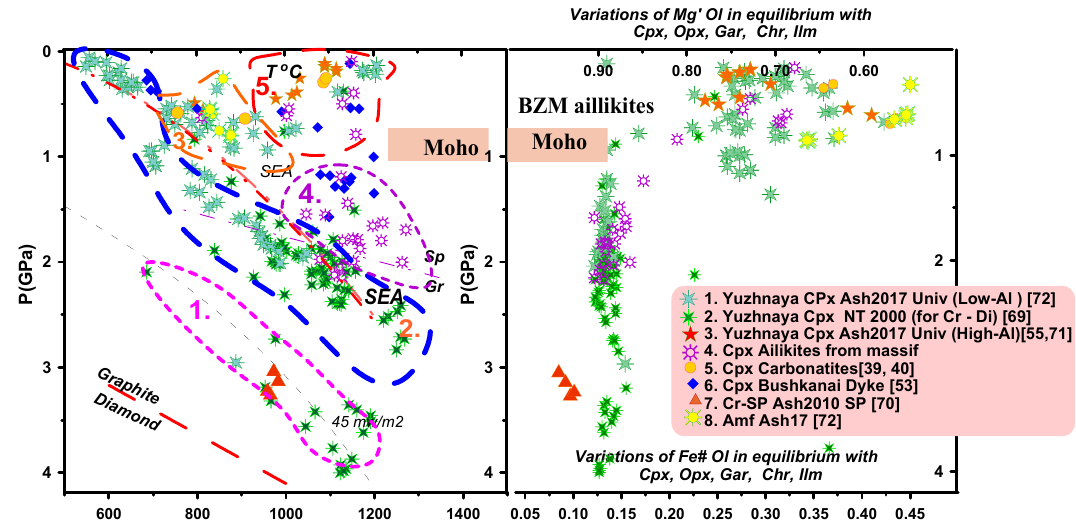
Figure 20. PT conditions for xenocrysts of aillikites BZM defined according to the mono-mineral thermobarometry for Cr-diopsides [69] and other pyroxenes [70–72]; for amphiboles [73] and for Cr-spinels [70].